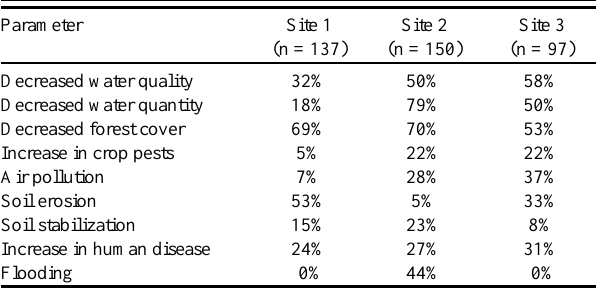
Table 8 . Environmental impacts observed by all stakeholder groups in each research site (% of respondents reporting issues of